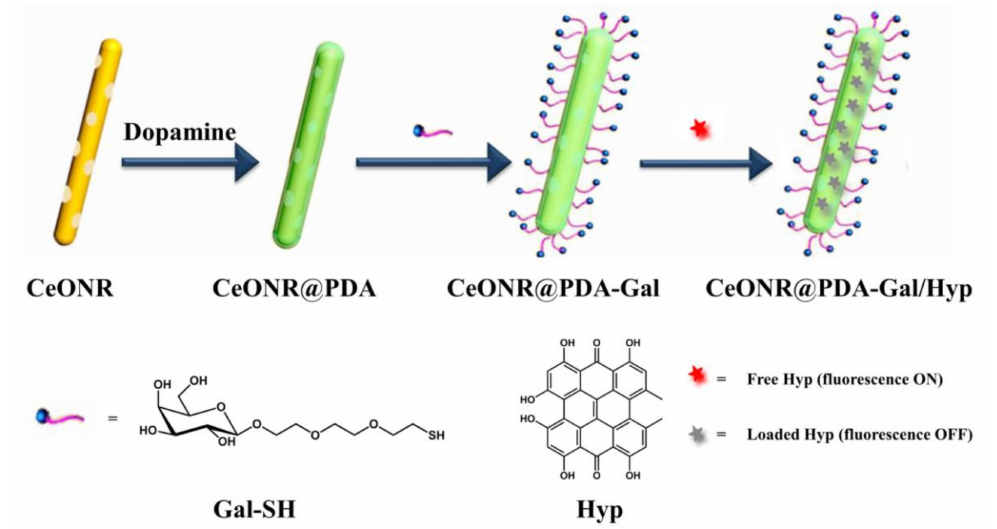
Scheme 1. Illustration of the construction process of CeONR@PDA-Gal / Hyp.